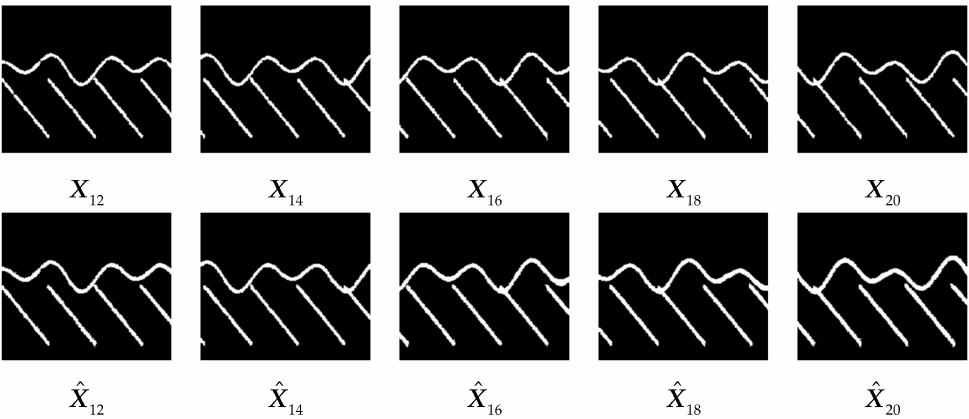
Figure 7. The prediction results for the mixed WBI. The first row shows the ground truth and the second row shows the predicted